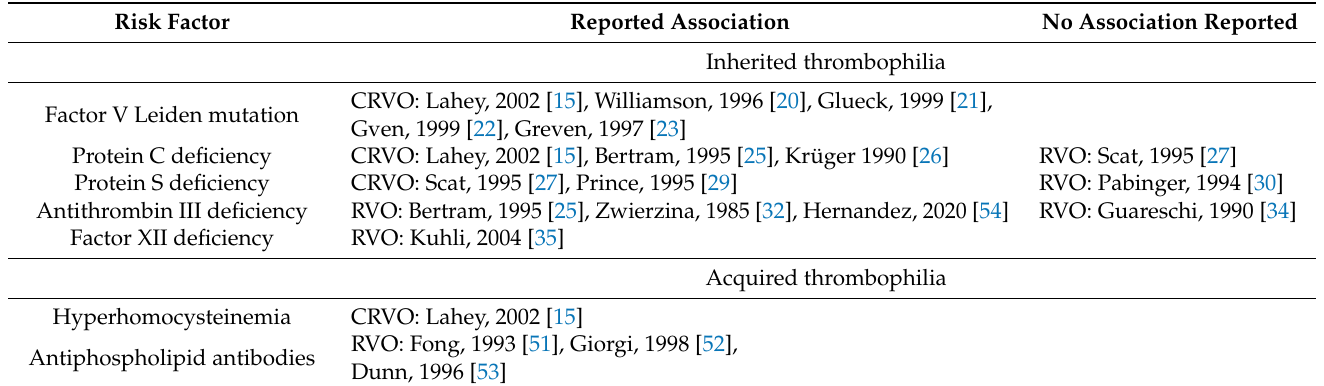
Table 1. Risk factors of RVO associated with coagulation/anticoagulation disorders